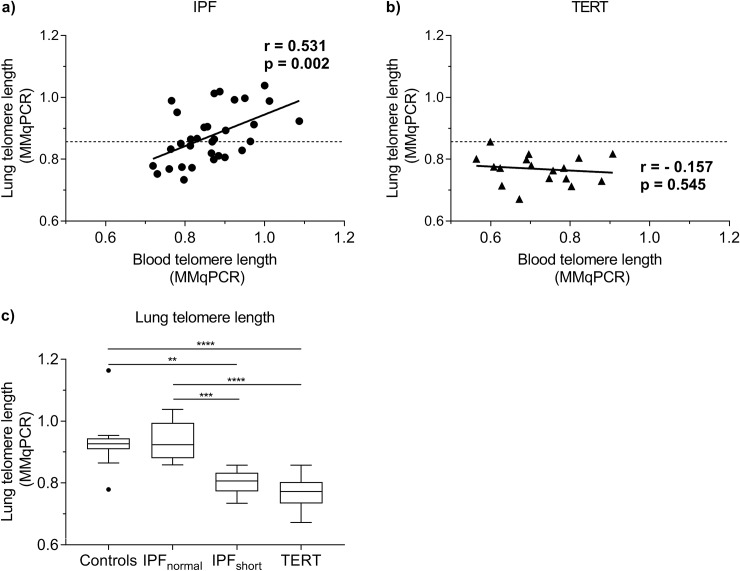
Blood and biopsy telomere length in IPF and TERT subjects measured by MMqPCR.(a, b) Spearman correlation of blood and biopsy telomere length in (a) 32 IPF and (b) 17 TERT cases. A significant positive correlation was established in IPF cases (r = 0.531, p = 0.002). In TERT cases, no significant correlation was found (r = -0.157, p = 0.545). Dashed lines represents threshold for lung telomere length associated with telomere related pathology. IPFnormal = lung telomere length above threshold, IPFshort = lung telomere length below threshold. (c) Tukey boxplots of lung telomere length measured by MMqPCR in control (n = 13), IPFnormal (n = 17), IPFshort (n = 15) and TERT (n = 17) lungs. Lung telomere length in the IPFshort group was significantly shorter than telomere length in age-matched controls (p = 0.0014) and IPFnormal (p = 0.0001). Telomere length in the TERT group was also significantly shorter than telomere length in controls (p < 0.0001) and in IPFnormal (p < 0.0001). Telomere length in the IPFnormal group and controls were comparable. Asterisks indicate significant differences calculated by Kruskal-Wallis multiple comparison tests (** = p < 0.01, *** = p < 0.001, **** = p < 0.0001). Boxes represent data between 1st and 3rd quartile and whiskers extend to the highest and lowest values of expression that are not considered outliers.